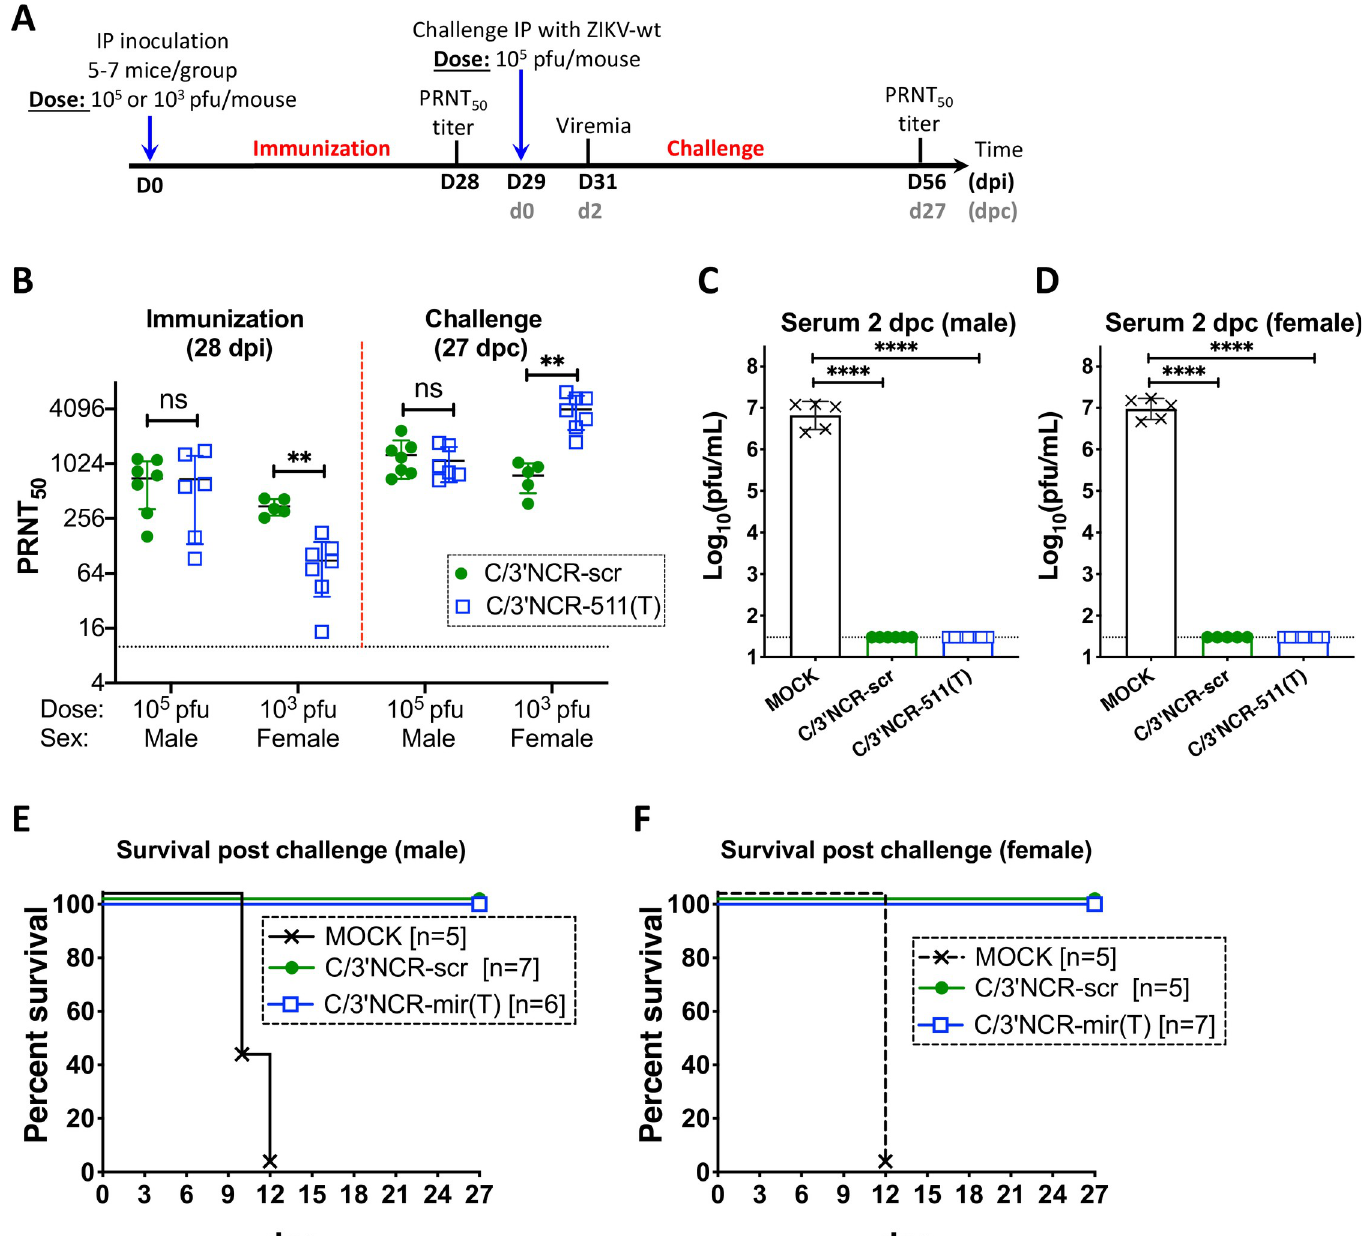
Fig 7. Immunogenicity and protective efficacy of the ZIKV containing multiple copies of mir-511-3p target sequences in AG129 mice. (A) Adult male or female AG129 mice were mock inoculated (n = 5) or IP infected with 10 5 (male) or 10 3 (female) pfu of C/3’NCR-511(T) or C/3’NCR-scr. On dpi 28 and 56, animals were bled to determine NA titer, which is presented as mean ± SD ( B ). On dpi 29, animals were challenged IP with 10 5 pfu of wt ZIKV (strain Paraiba_01/2015). At 2 days post challenge (dpc) mice were bled to determine viremia ( C, D) and monitored for survival ( E, F ). The dashed lines indicate the limit of virus detection in the serum [1.5 log 10 pfu/mL ( C, D )] or indicate the limit of NA titer detection ( B ). Differences between viral titers in the serum were compared using two-way ANOVA ( C, D ). Differences between NA titers were compared using two-tailed Mann-Whitney test ( B ). �� p < 0.01; ���� p < 0.0001; ns denotes p > 0.05. Data for male and female mice is presented as a summary of two and one independent experiments,